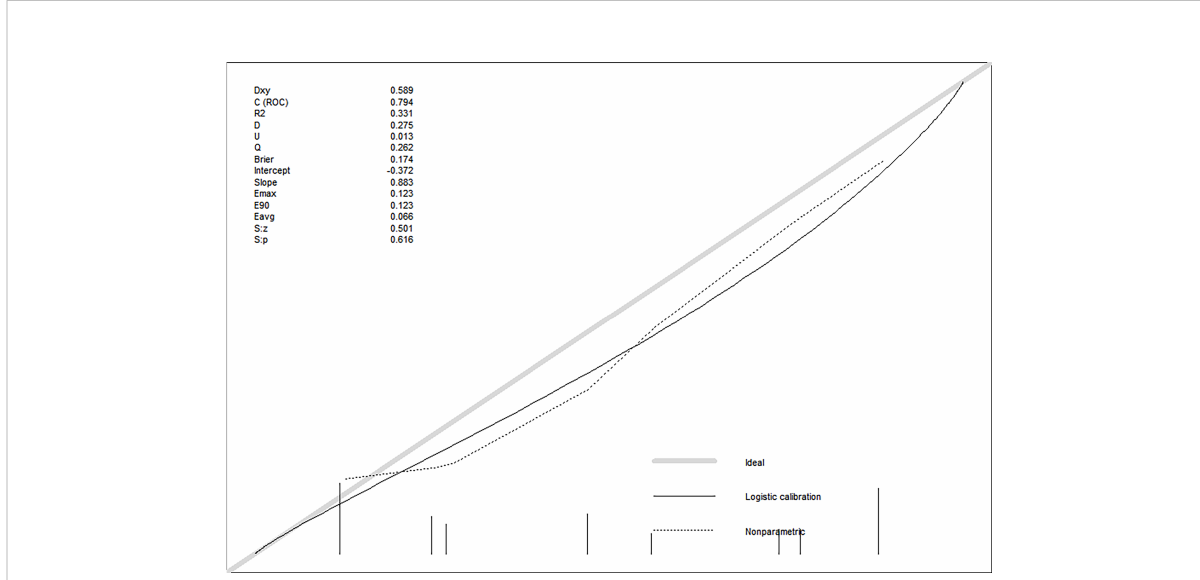
FIGURE 5 The discrimination and calibration curves of prediction